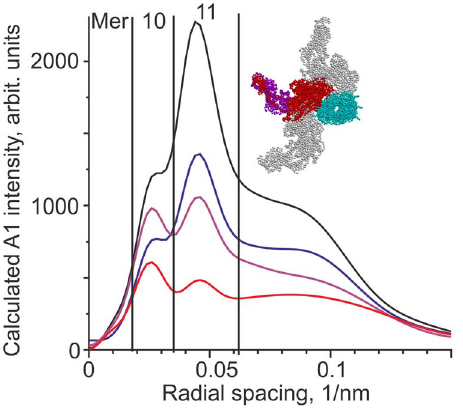
Figure 5. Calculated intensity of the A1 actin layer line. The blue line corresponds to 40% of the total number of myosin heads bound to actin stereo-specifically by only one of the two heads of a myosin molecule. The black line corresponds to 60% of myosin heads stereo- specifically bound to actin: 20% of myosin molecules with one head only and the other 20% with both their heads. The purple and red lines correspond to non-stereo-specific attachment of the same 60% of heads with random uniform distribution of the azimuthal orientation angles within ranges of 60 u or 80 u , respectively. The vertical lines show the integration ranges for meridian (Mer), and the 10 and 11 row lines used for the experimental data shown in Fig. 3. Inset shows an actin filament (cyan, viewed along the filament axis) with a pair of stereo- specifically bound myosin heads (red heavy chains, magenta light chains). The same pair rotated by 6 60 u is shown in gray.